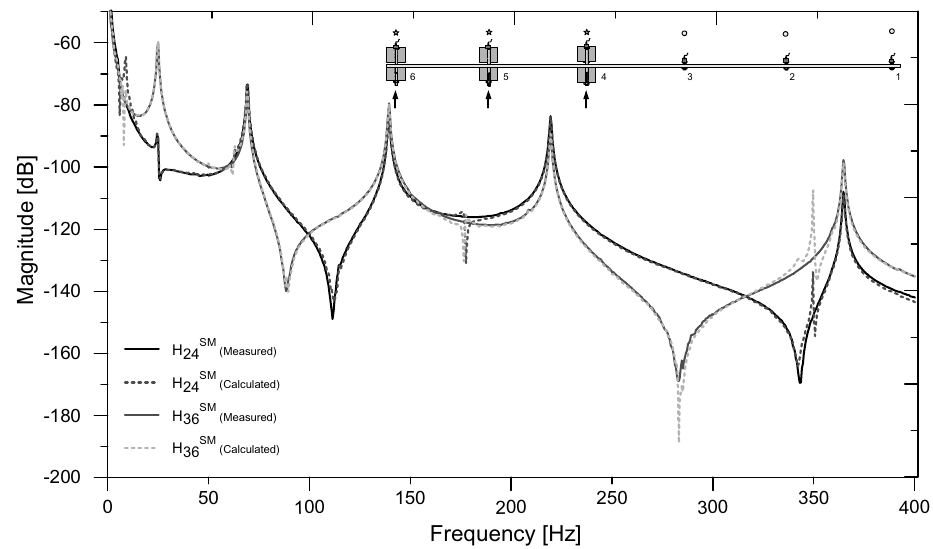
Fig. 13. Measured and estimated Receptances H (cid:2) 24 and H (cid:2) 36 for the SM structure (Case I).